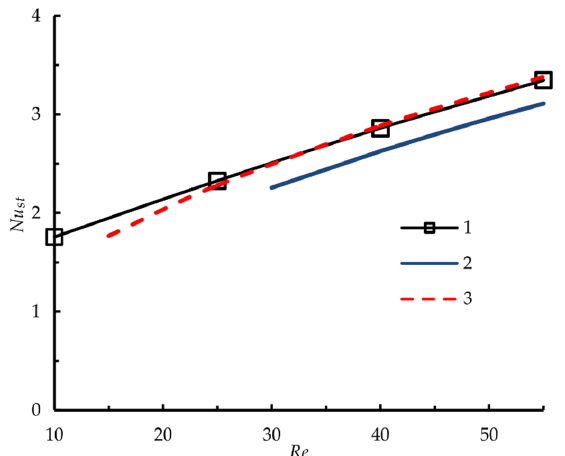
Figure 6. Verification of numerical simulation: 1– Present study; 2 – Mancin et al. [56]; 3 – Calmidi et al. [57].